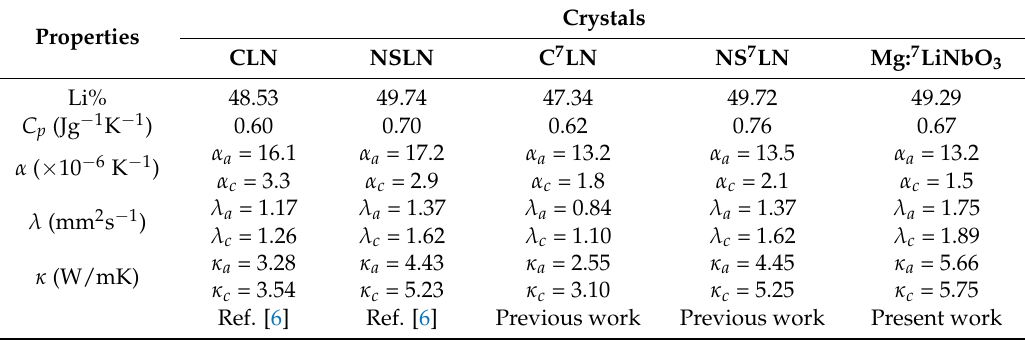
Table 1. Experimental results of the as-grown Mg: 7 LiNbO 3 crystals in the present work and of the undoped 7 LiNbO 3 crystals in our previous work [18], as well as of the natural LiNbO 3 crystals published by our team [6]. The values of specific heat ( C p ) were determined at 328 K, the thermal diffusion coefficients ( λ ) and thermal conductivity ( κ ) were determined at 300 K, and the average thermal expansion coefficients ( α ) were obtained between 298 and 773 K. C 7 LN—congruent isotope lithium niobate; NS 7 LN—nearly stoichiometric isotope lithium niobate; CLN—congruent